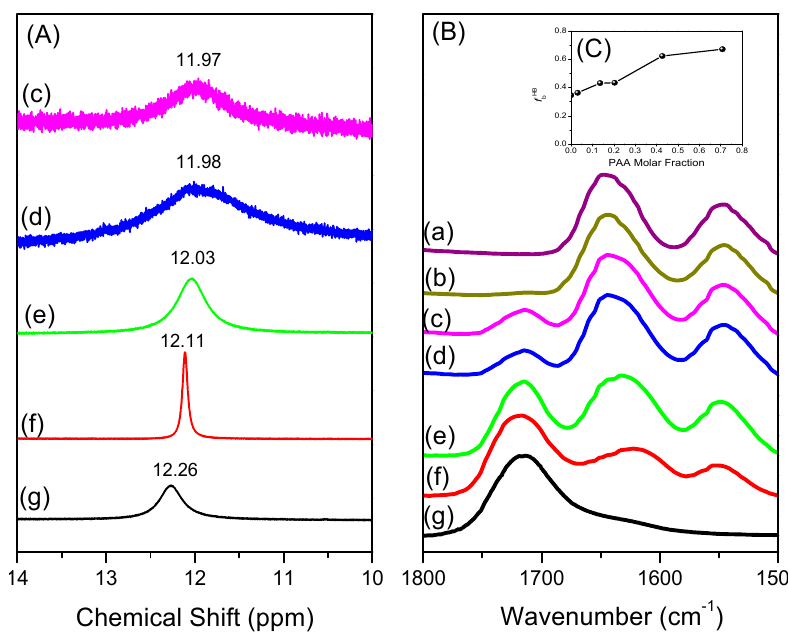
Figure 4. ( A ) 1 H NMR spectra, presented in the range 14–10 ppm, displaying the signal of the proton of the acrylic acid units. ( B ) FTIR spectra in the range 1800–1500 cm − 1 displaying the COOH and